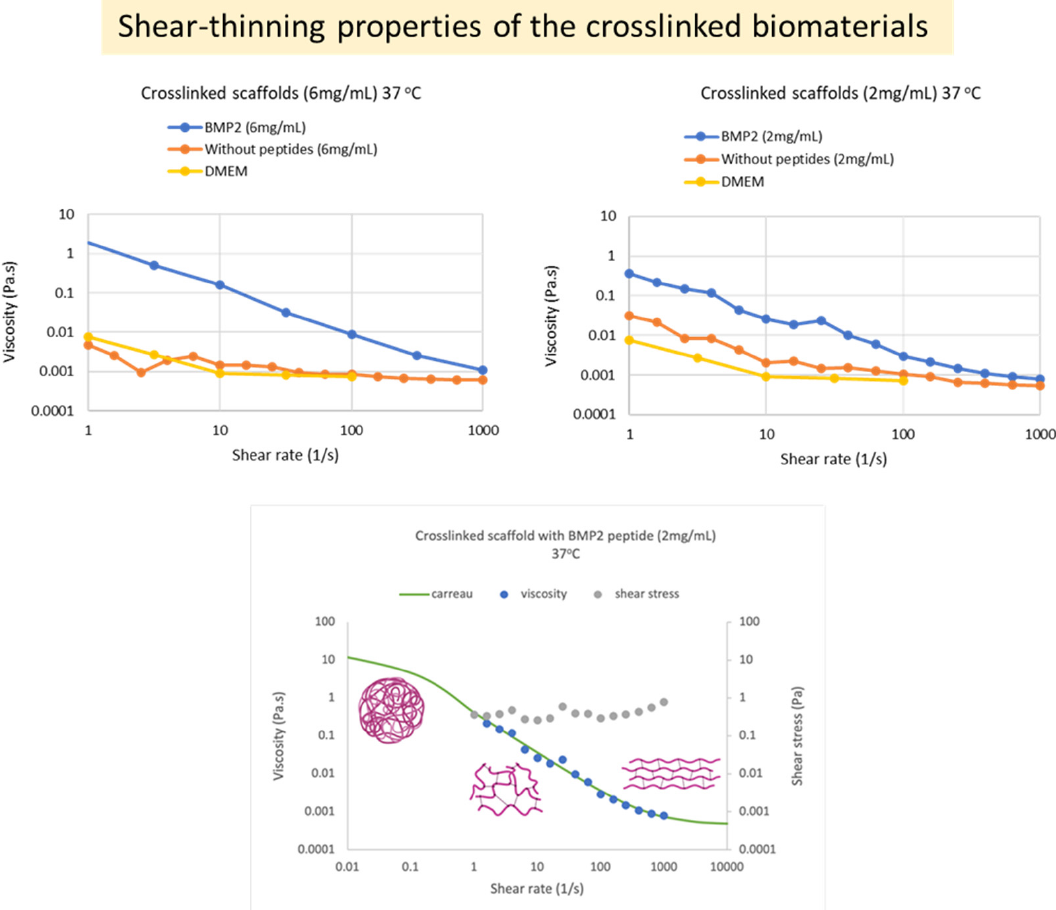
Figure 7. Determination of the shear-thinning properties of the crosslinked biomaterials at 37 °C (flowstep plots). The viscosity of the crosslinked scaffold-BMP2 decreases with increasing shear rate, indicating that the material is strongly shear thinning. The schematics show the proposed gradual acquisition of a common orientation of the fibers of the material with the increasing shear rate. Schematics were created with BioRender.com.